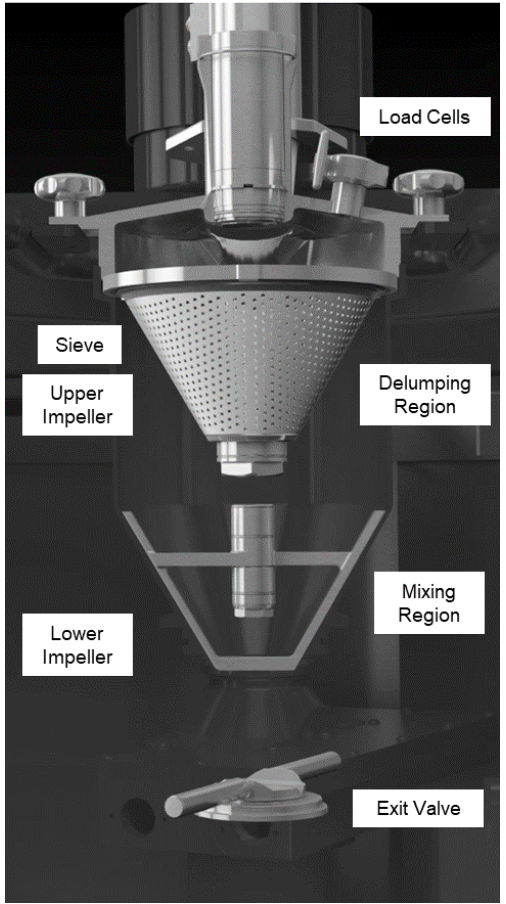
Figure 3. Overview of the CMT. View of the upper impeller is obstructed by the sieve.